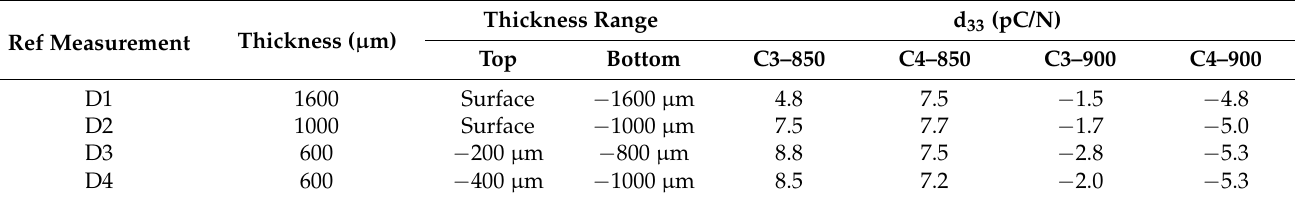
Table 7. Piezoelectric charge